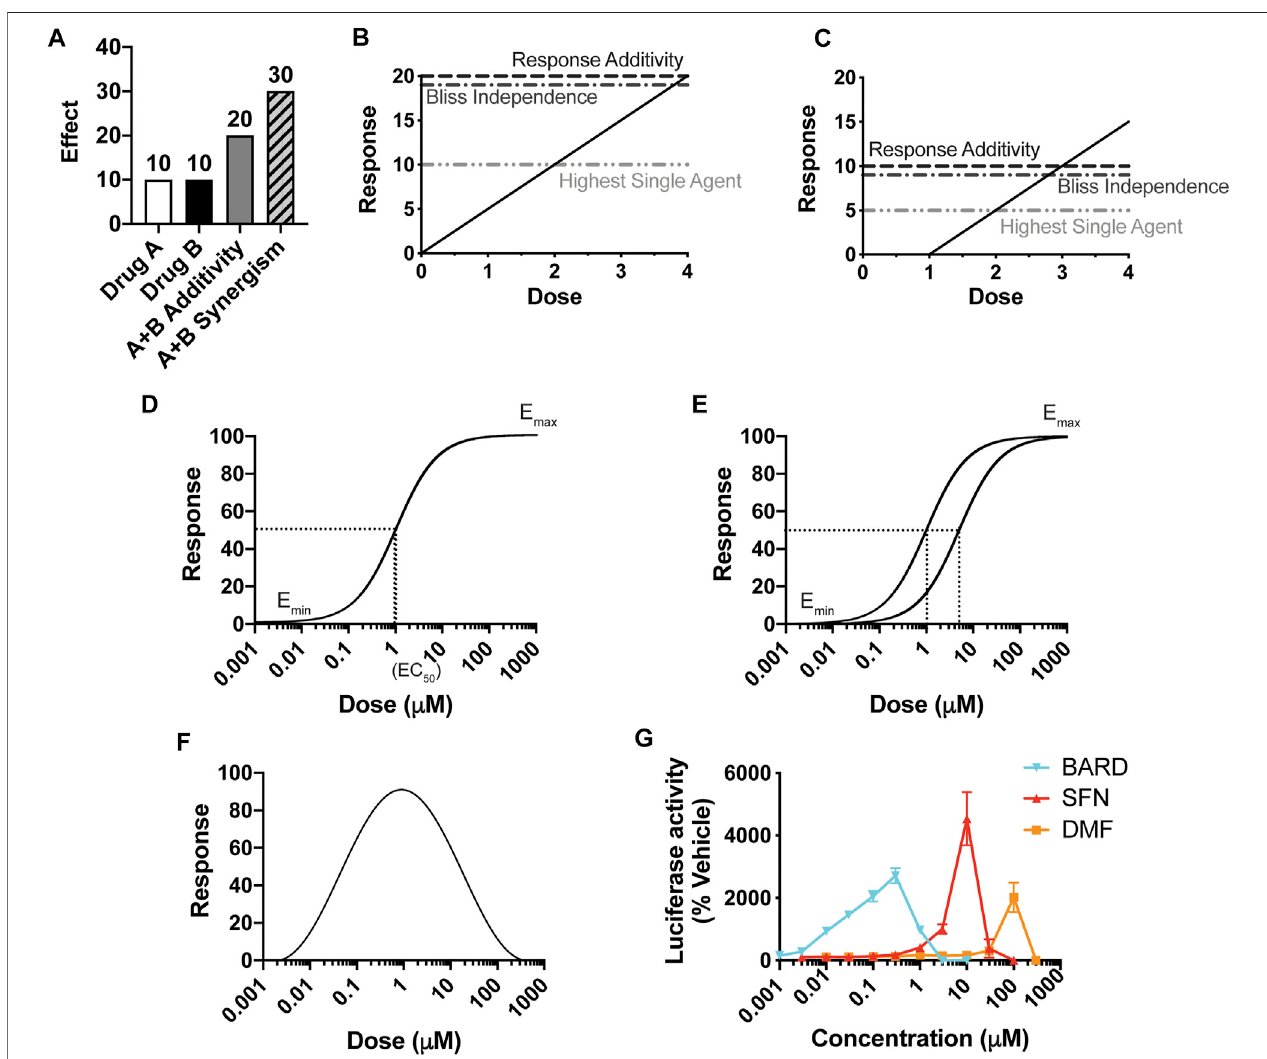
FIGURE 1 | The importance of a dose response curve, and its overall shape, for the prediction of synergy. (A) The de fi nition of synergy by the effect-based Response Additivity method, where the predicted additive effect is the sum of the effects of Drug A and Drug B, and actual effects that are greater than this sum are synergistic. (B,C) TheShamCombinationtestforthreecommon “ effect-based ” methods,forwhichtheeffectsofsingledosesdeterminethepredictedadditiveeffect.A single drug plays the role of both Drug A and Drug B, and thus the actual additive effect is known; here it is the effect of a dose of (2 + 2) (cid:1) 4, with a corresponding response of 20 in (B) and 15 in (C) . Only for (B) , in which y (cid:1) mx, does the predicted additive effect match the actual one. (D) A classic Hill-slope curvilinear fi t, which approachesamaximumeffect. (E) TwoHill-slopecurveswitha “ constantpotencyratio, ” whichrequiresequivalentHill-slopes(parallelcurvesonalog-scaled x -axis)and thesameeffectat100%response. (F) Ahormeticdosingcurve,whichhasabiphasiceffect,hereshownasdecreasingatincreasingconcentrations. (G) Dose-response curves for three Nrf2/ARE activators in clinical use or in clinical trials.